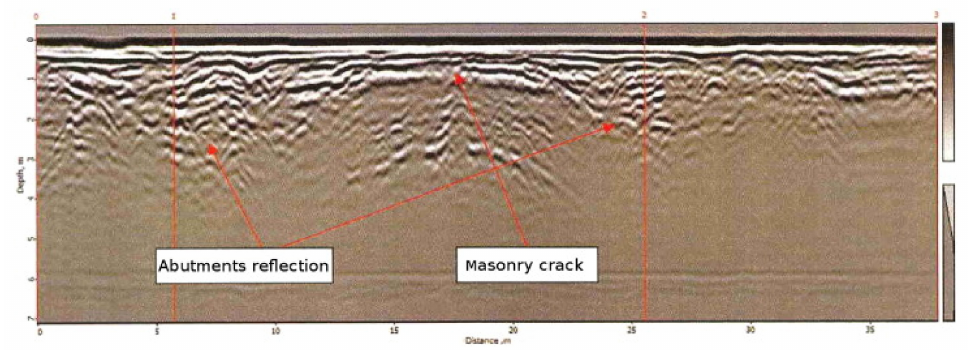
Figure 7. GPR profile above the deck of a historical masonry arch bridge